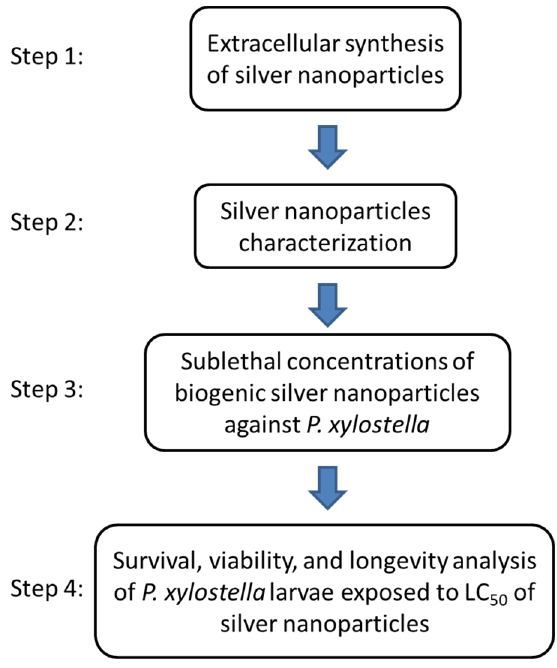
Figure 1. Experimental procedure flowchart. Table 1. Entomopathogenic fungi isolates used in this